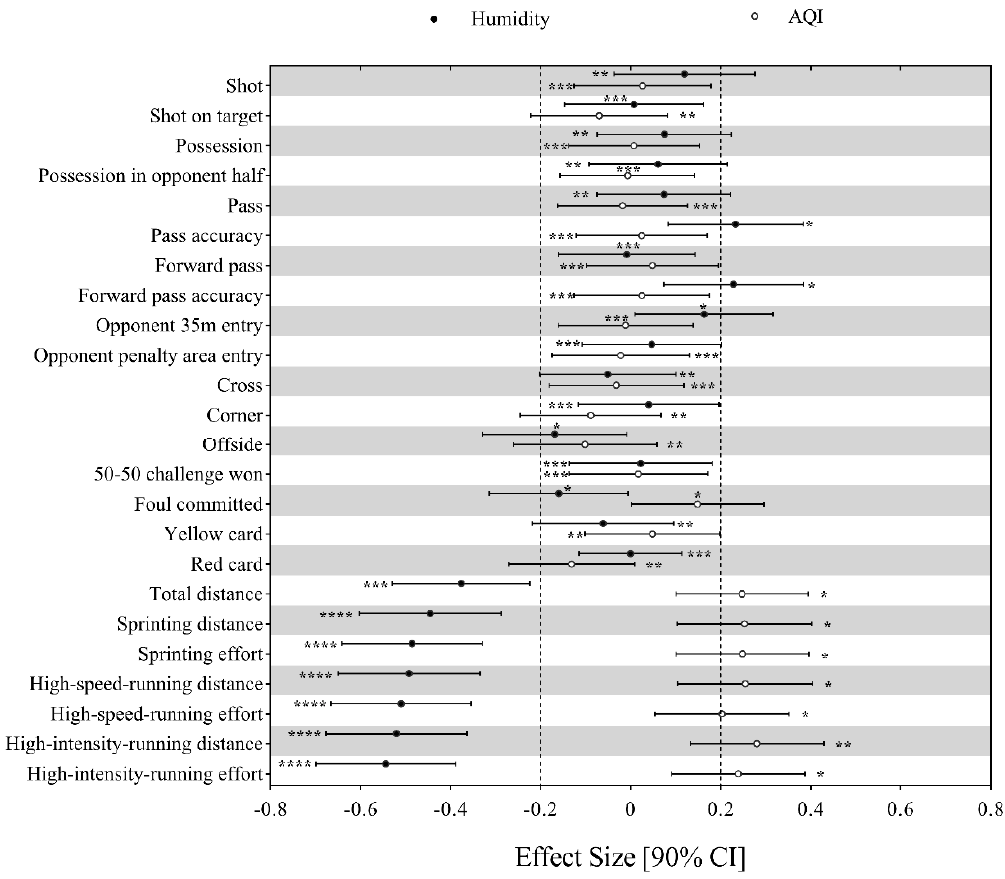
Figure 2. Effects of humidity and AQI (Air quality index) on the technical and physical performance of CSL teams. Effects are shown as the effect of an increase of two standard deviations in the value of humidity and AQI on the difference of each performance-related parameter. Dotted lines represent the smallest worthwhile difference. Asterisks indicate the likelihood for the magnitude of the true effect as follows: * possible; ** likely; *** very likely; **** most likely. Asterisks located in the trivial region denote likelihood of trivial effects.